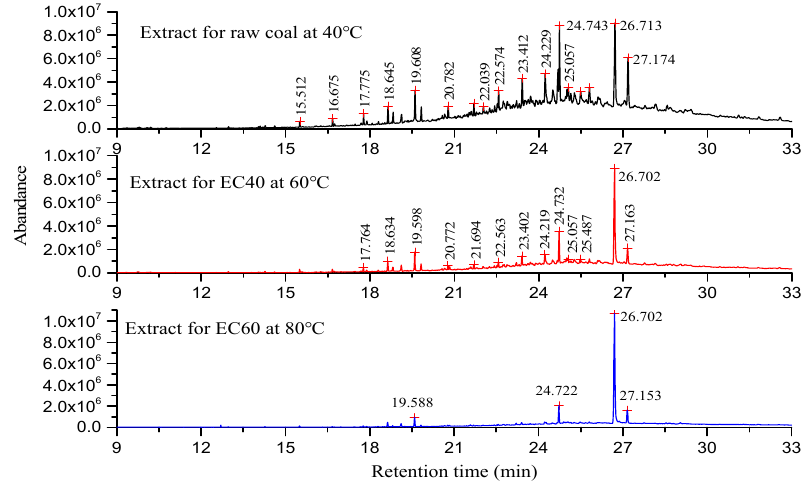
Figure 4. Total ion chromatograms of extracts from Neimeng coal.